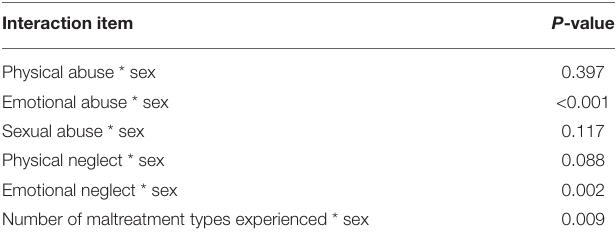
TABLE 4 | Interaction effects between child maltreatment and sex on depressive